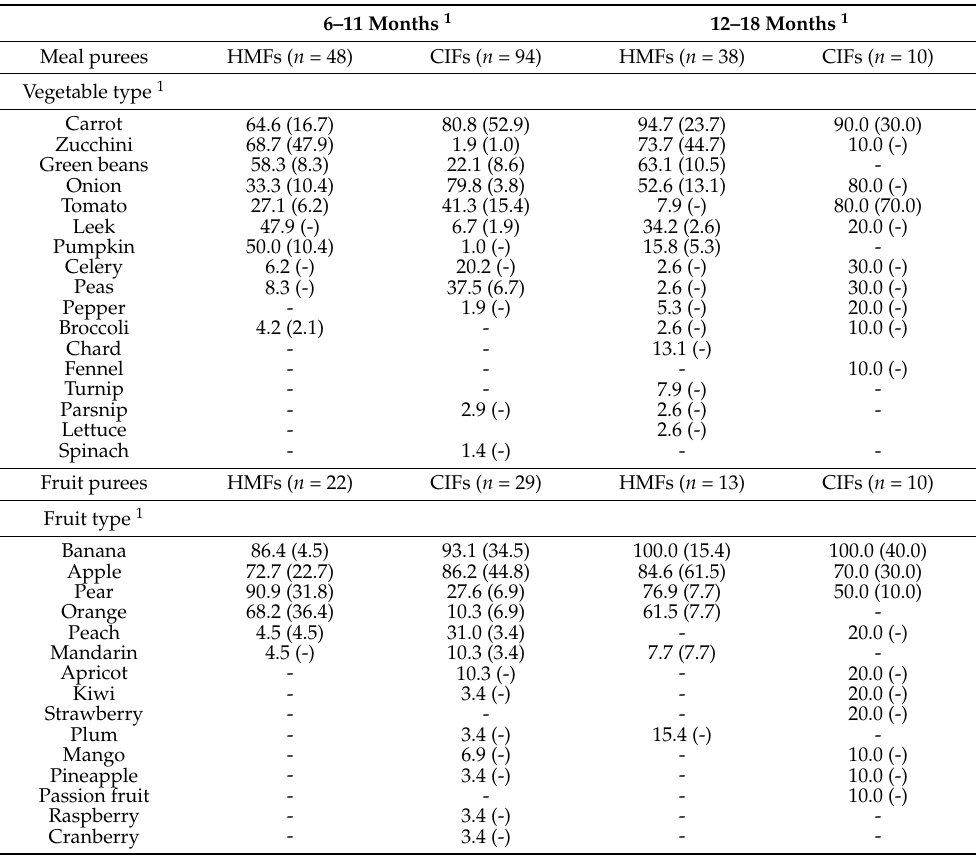
Figure 1. Food variety in HMFs and CIFs meals and fruit purees for infants (6–11 months) and young children (12–18 months). (Percentages of meals and fruit purees containing each of the different ingredients). Table 4. Percentage of HMFs and CIFs including different vegetables and fruits in meals and fruit purees for infants (6–11 months) and young children (12–18